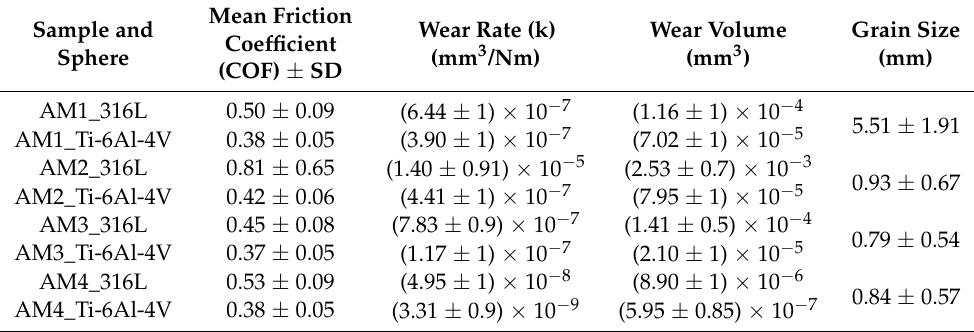
Table 4. COF, specific wear rate, and worn volume measured during wear tests using 316L and Ti-6Al-4V spheres against the Co-Cr-Mo alloy